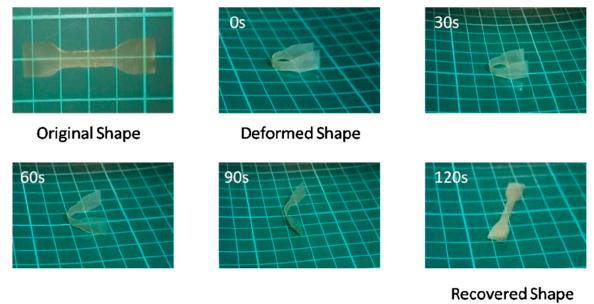
Figure 7. Shape memory process of the PBLG-PPG-PBLG film at 100 °C.